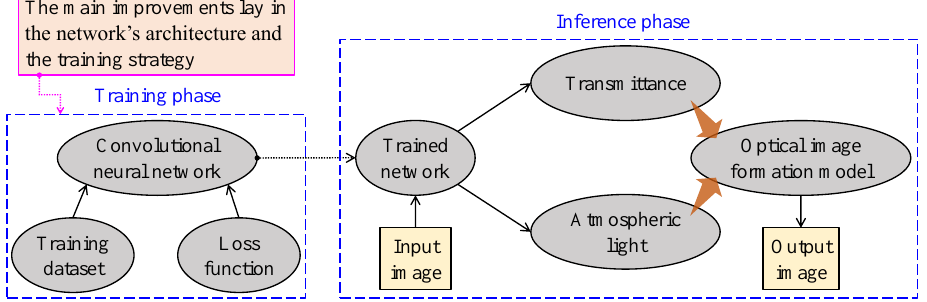
Figure 11. Simplified block diagram of convolutional neural network-based visibility restoration algorithms. Generative adversarial network (GAN): another deep learning framework, known